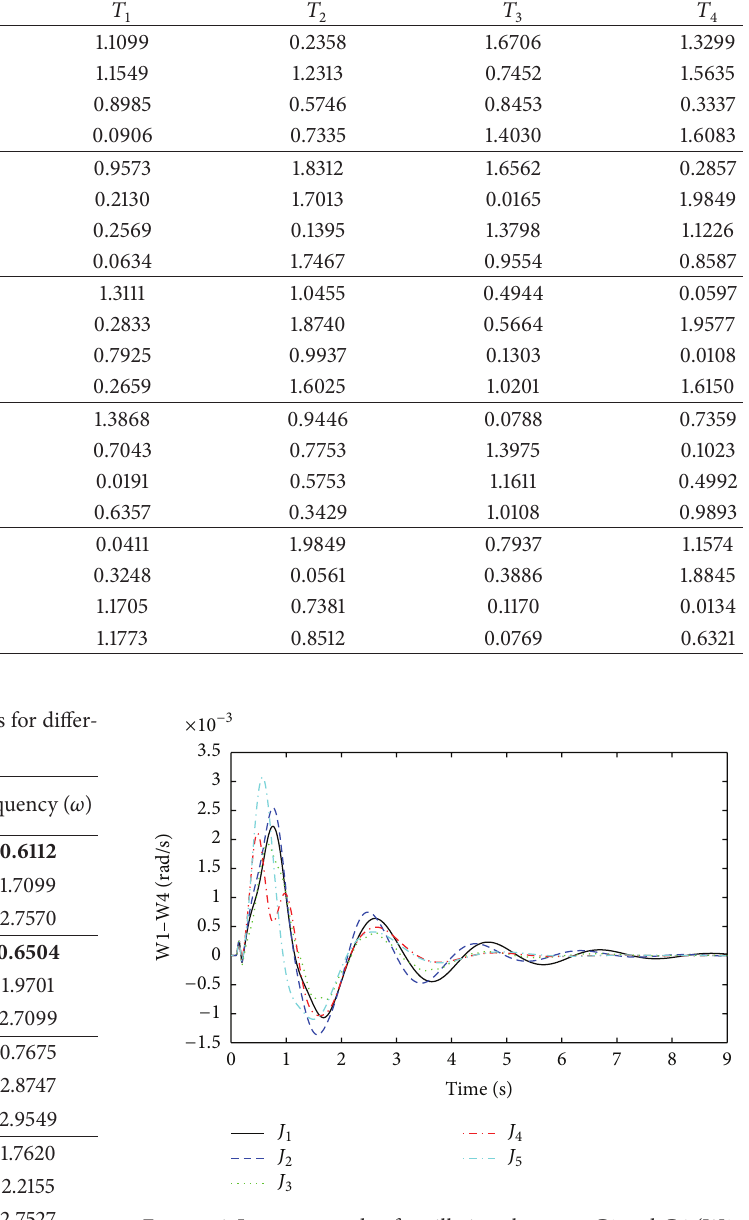
Figure 6: Interarea mode of oscillations between G1 and G4 (W1– W4) for threephase fault at bus